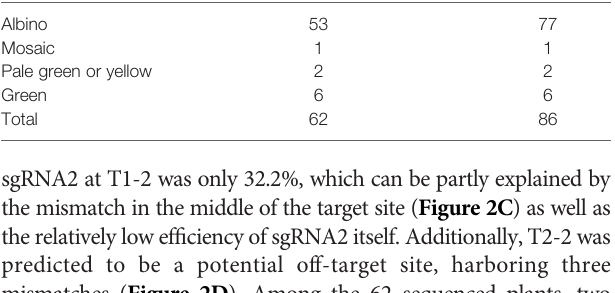
TABLE 1 | Summary of the phenotypes of the T 0 transgenic plants.